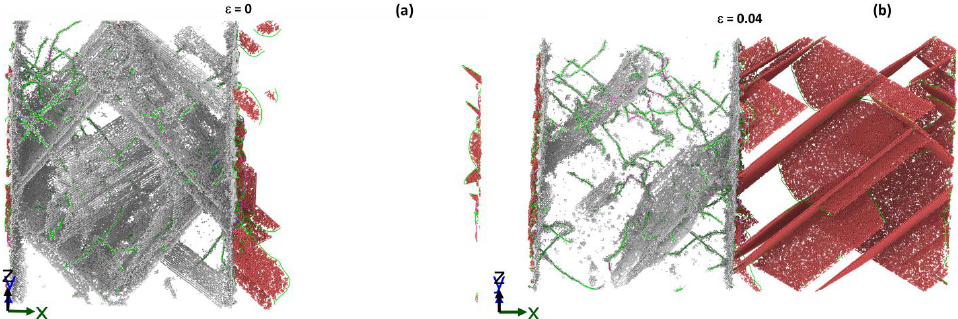
Figure 9. ( a ) Initial state of Al-Cu bisystem before deformation at the initial pressure of 40 GPa. In aluminum, one can see the boundaries between subgrains and dislocation lines that appeared at the stage of bringing the system to the target pressure. In copper, there are dislocation half-loops that arise at the stage of stress relaxation. ( b ) Development of plastic deformation in the system. In the aluminum part, the grain boundaries are displaced and the grain grows, which is the most favorably oriented towards the deformation, and the sliding of the existing dislocations is also realized. In copper, stacking fault planes grow and a system of twins is formed. Aluminum atoms are grey colored, copper atoms are red colored.